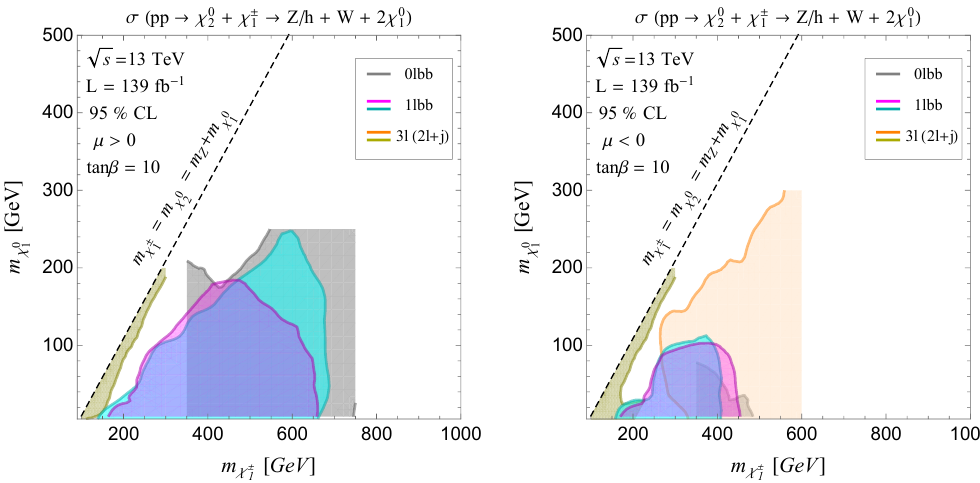
Figure 7 . 95% confidence level bounds on the Wino-Bino scenario projected to integrated luminos- ity L = 139 fb − 1 , assuming tan β = 10 , | µ | = 2 TeV, and M SUSY = 10 TeV. The labels are similar to figure